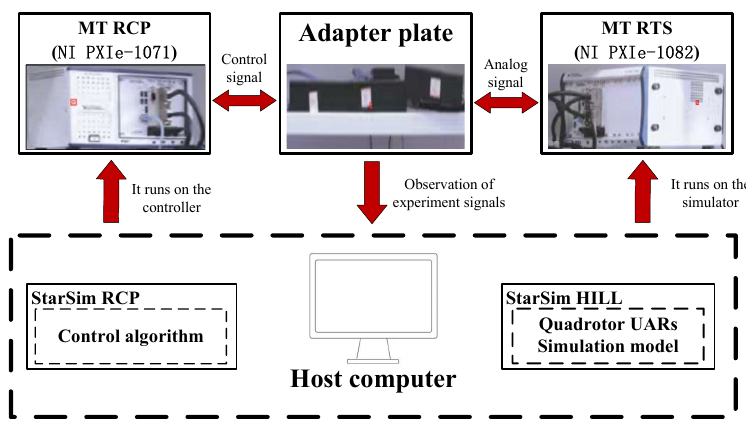
Figure 4. The structure of the experimental system.